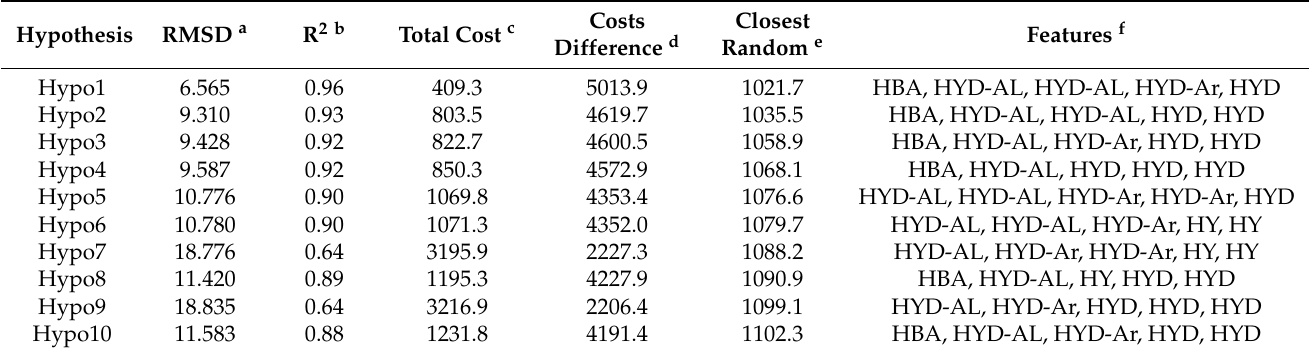
Table 4. Parameters of 10 generated PH4 pharmacophoric hypotheses for the Pf ENR inhibitor after the CatScramble validation procedure (49 scrambled runs for each hypothesis at the selected confidence level of